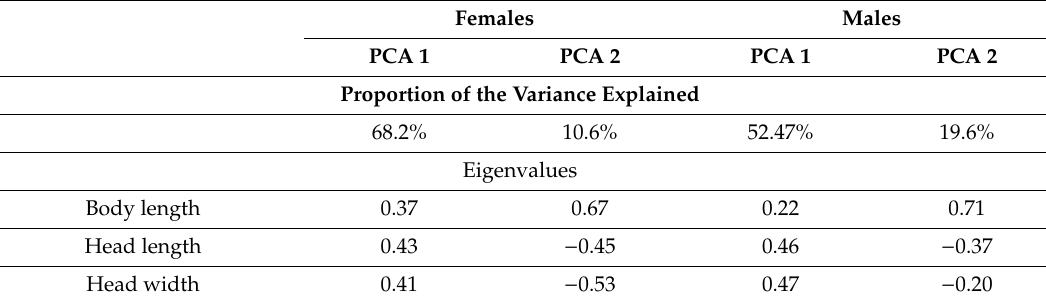
Table 2. Summary statistics from principal component analysis